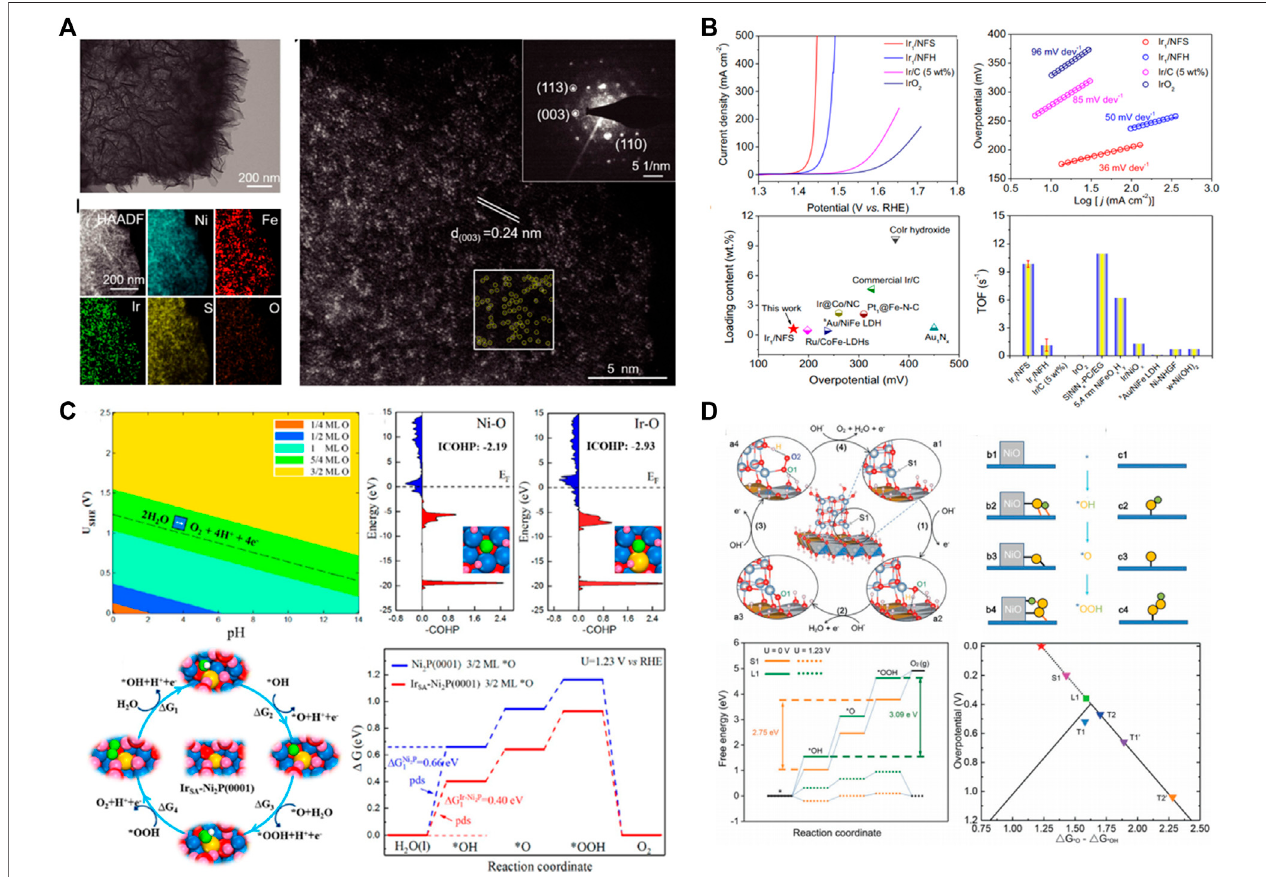
FIGURE 1 | (A) Electron microscope analysis of Ir 1 /NFS. (B) Electrochemical OER performance of Ir 1 /NFS, Ir 1 /NFH, Ir/C (5 wt%), and IrO 2 in 1.0 M KOH. (C) DFT calculation indicated that the isolated Ir-O-P/Ni-O-P bonding can optimize the adsorption energy of OER intermediate species to accelerate the adsorption/desorption process. (D) Structure model and DFT + U calculation results of NiO/NiFe LDH